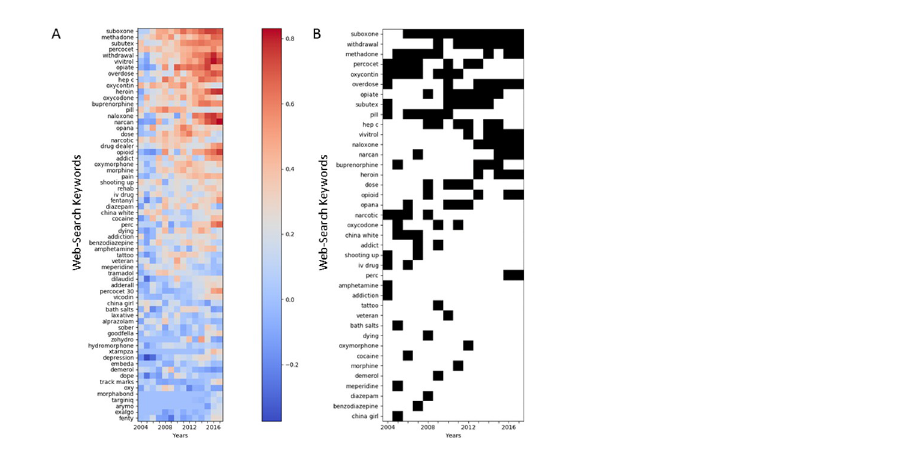
Fig 2. Changes across time. (A) Correlation of 80 Keywords with observed Overdose Death (ODD) Rates for Each Year, 2004–2017, Keywords Are Sorted from the Highest to the Lowest Average Correlation Across All Years; (B) Keywords in the Top 10 (Shown in Black) by Correlation with observed ODD Rates for Each Year, 2004–2017.